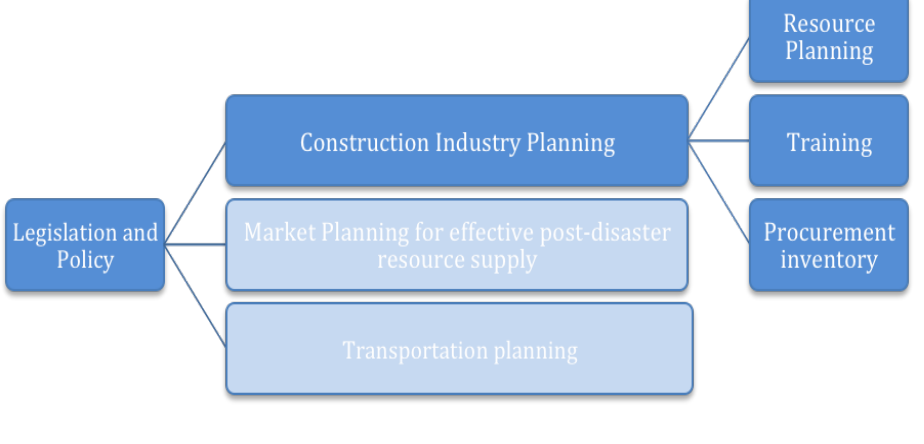
Figure 4 Integrated Planning Framework (adapted from Chang, et al.,